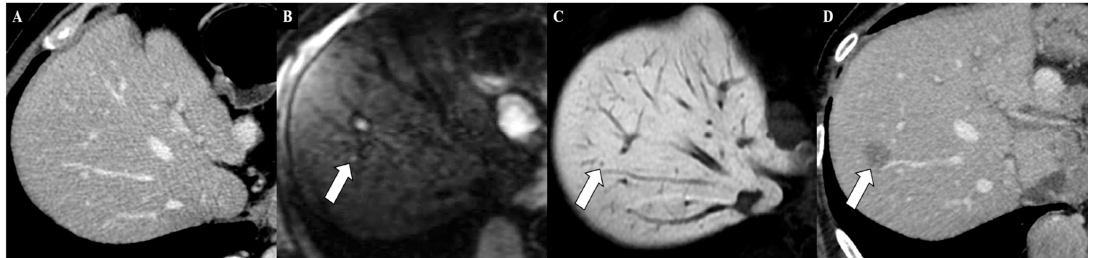
Figure 2. Axial contrast-enhanced computed tomography (CT) image ( A ), in the same patient, did not show metastatic lesions at this liver level. The axial gadoxetic acid-enhanced magnetic resonance imaging, performed using diffusion-weighted imaging ( B ) and during the hepatobiliary phase (C) , demonstrated a small liver metastasis in the liver segment VIII (white arrows). After six months, the axial contrast-enhanced CT image ( D ) confirmed the metastatic liver lesion (white arrow), enlarged.